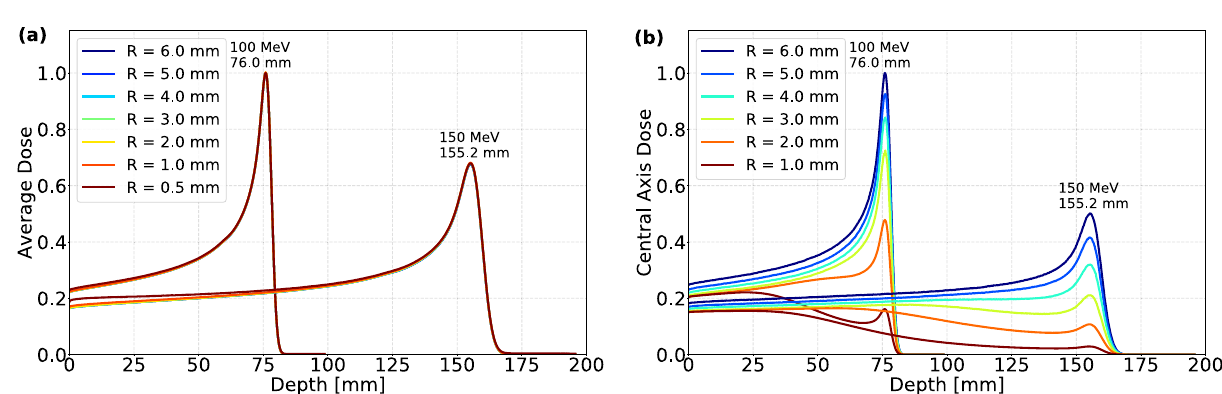
Figure 4. Longitudinal normalized dose profiles for CECP beams. Both ( a ) wide and ( b ) narrow cylindrical scoring volumes are used, indicating the overall dose and the central axis dose as a function of